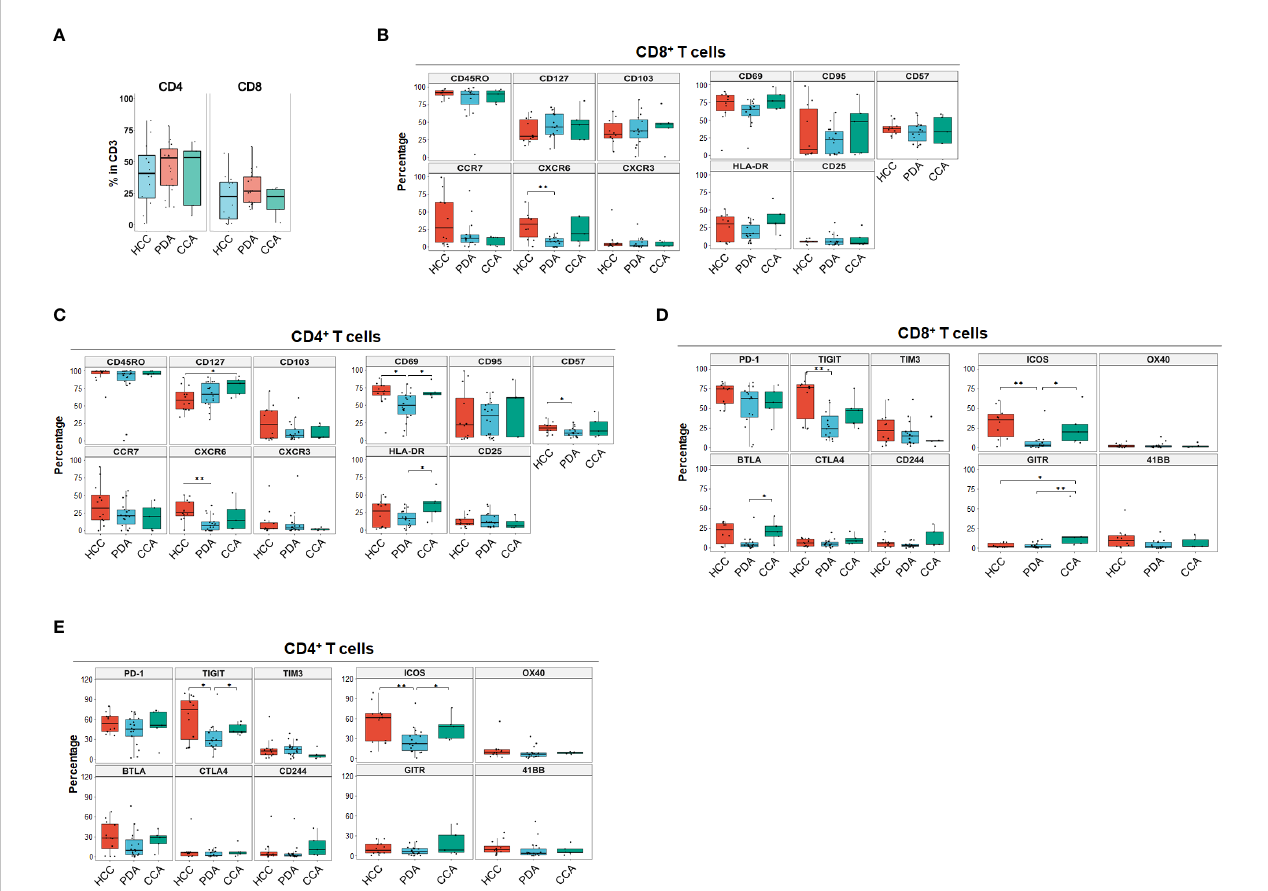
FIGURE 1 Landscape of T cell differentiation, activation state, inhibitory and stimulatory checkpoint receptors of tumor in fi ltrating T cells in HCC, PDA and CCA. (A) Percentage of CD4+ T cells and CD8+ T cells in CD3+ T cells in HCC (n=11), PDA (n=20) and CCA (n=5) patients. (B, C) Boxplots showing frequency of T cell differentiation markers and activation markers in CD8+ T cells (B) and CD4+ T cells (C) in HCC, PDA and CCA patients. Box middle lines, median; box limits upper and lower quartiles; box whiskers, 1.5x the interquartile range. Kruskal-Wallis test. (D) Inhibitory and stimulatory checkpoint receptors frequency of CD8+ T cell. Box middle lines, median; box limits upper and lower quartiles; box whiskers, 1.5x the interquartile range. *p < 0.05; ** p < 0.01; Kruskal-Wallis test. (E) Inhibitory and stimulatory checkpoint receptors frequency of CD4+ T cell. Box middle lines, median; box limits upper and lower quartiles; box whiskers, 1.5x the interquartile range. *p < 0.05; ** p < 0.01; Kruskal-Wallis